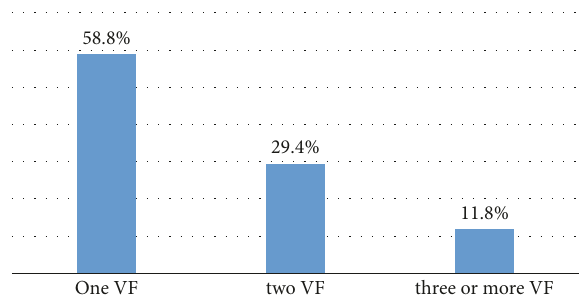
Figure 2: Distribution of number of fractures in patients assessed with vertebral